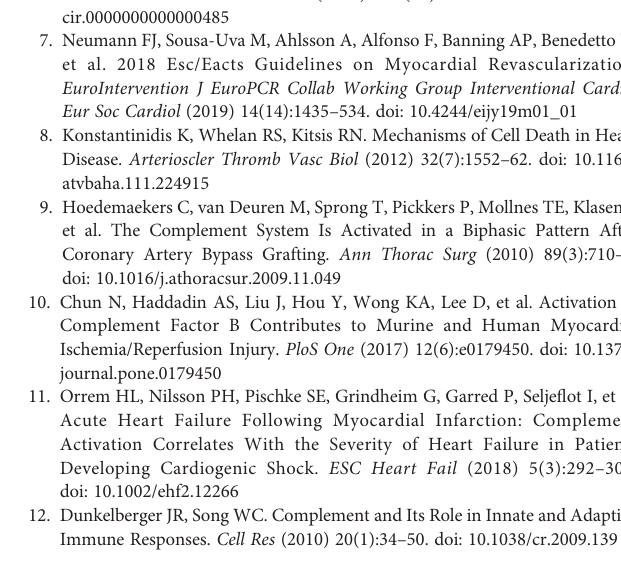
(C3KO) hearts exposed to ischemia-reperfusion. Hearts were exposed to 20 minutes stabilization, 35 minutes ischemia and 60 minutes of reperfusion and left ventricular (LV) function was measured. (A) heart rate, (B) rate pressure product (RPP), (C) coronary fl ow, and (D) LV developing pressure (LVdevP). Data sets are displayed as mean ± SEM. Supplementary Figure 2 | Extracellular C3a treatment of cardiomyocytes. (A) Activation of Akt (presented as p-Akt/total Akt) was measured in cardiomyocytes treated with extracellular C3a (10 and 100 µg/mL mouse recombinant C3a (R&D systems, Minneapolis, MN) or 10 and 100 µg/mL human C3a (Complement Technology, Inc., Tayler, TX)), n=4. Data set is displayed as scatterplots with median. Supplementary Figure 3 | Metabolites in mouse WT and C3KO hearts. Complement component 3 knock out (C3KO) and wild type (WT) hearts were analyzed with an untargeted metabolomic scan by Human Metabolome Technologies, n=6. Signi fi cant metabolites (A – P) are presented as relative area. Data sets are displayed as scatterplots with median. Supplementary Figure 4 | Lactate and succinate measurements in coronary perfusate. Isolatedheartsfromwildtype (WT)and complementcomponent 3 knock out (C3KO) were exposed to 20 minutes stabilization, 35 minutes ischemia, and 1 minute reperfusion. Coronary perfusates were collected at end of stabilization as a baseline. Subsequently at 0-30 seconds and 30-60 seconds during reperfusion. (A) Lactate and (B) succinate, n=4-8. Data sets are displayed as scatterplots with median. Supplementary Figure 5 | IL-6 release in coronary perfusate. Isolated hearts from wild type (WT) and complement component 3 knock out (C3KO) were exposed to 20 minutes stabilization, 35 minutes ischemia, and 60 minutes reperfusion. Coronary perfusates were collected and IL-6 release was investigated. Data set is displayed as mean ±